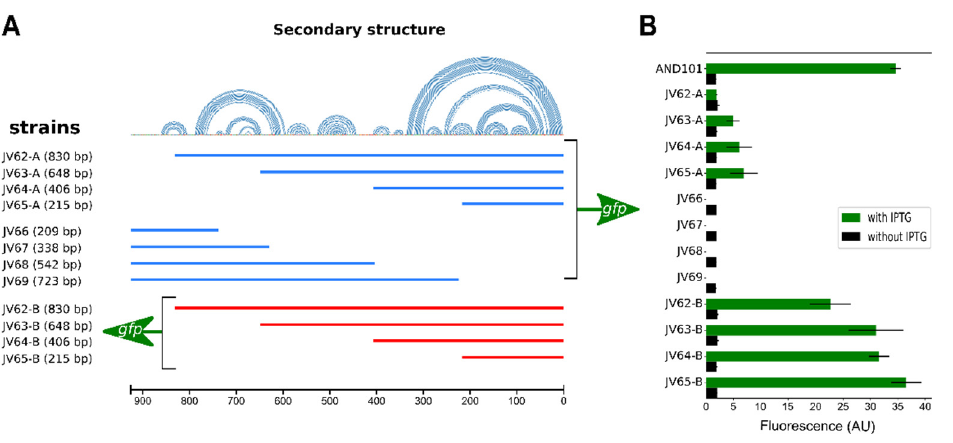
Figure 3. EGeRS1-B located upstream of ardC pLS20 does not contain a regular promoter, but its presence prevents readthrough from upstream promoters. ( A ) Schematic overview of the gfp fusions generated. 5 ′ deletion fragments were cloned in both orientations between the IPTG-inducible promoter P spank and the gfp reporter gene in vector pAND101. 3 ′ deletion fragments were cloned in the native orientation. Names of the B. subtilis strains containing these gfp fusions at the chromosomal amyE locus are shown at the left; names ending with letter “A” and “B” correspond to strains containing the cloned fragment in the native and reverse orientations, respectively. The secondary structures predicted to form in ssDNA or RNA are indicated with arcs above the lines representing the cloned regions. ( B ) Fluorescence levels of cells taken from late exponentially growing cultures (OD 600 = 1) of strains grown in the absence (black bars) or presence of 1 mM IPTG (green bars). Strain AND101 (P spank - gfp ) served as a control. Error bars indicate standard deviations. Each experiment was performed at least three times.